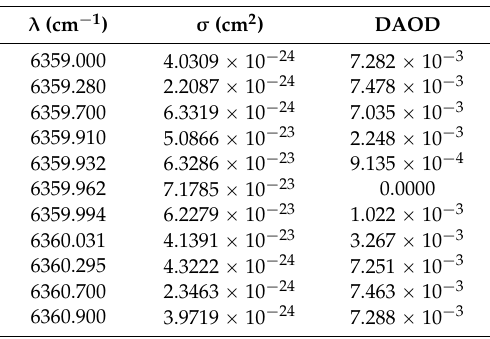
Table 2. Parameters of the selected points in the MW-DIAL.